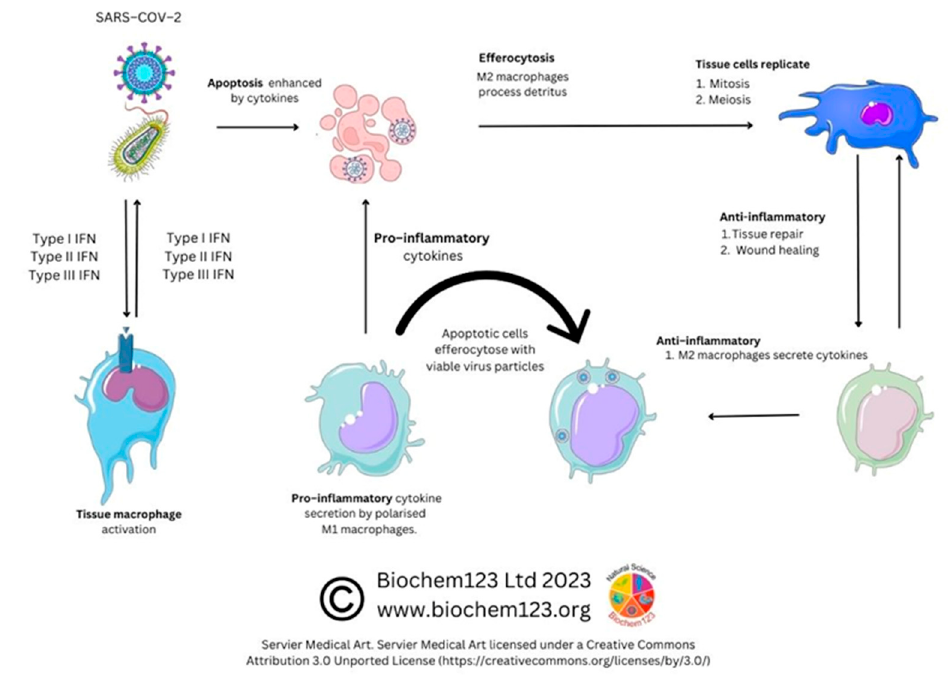
Figure 6. Macrophage process and role in infection.